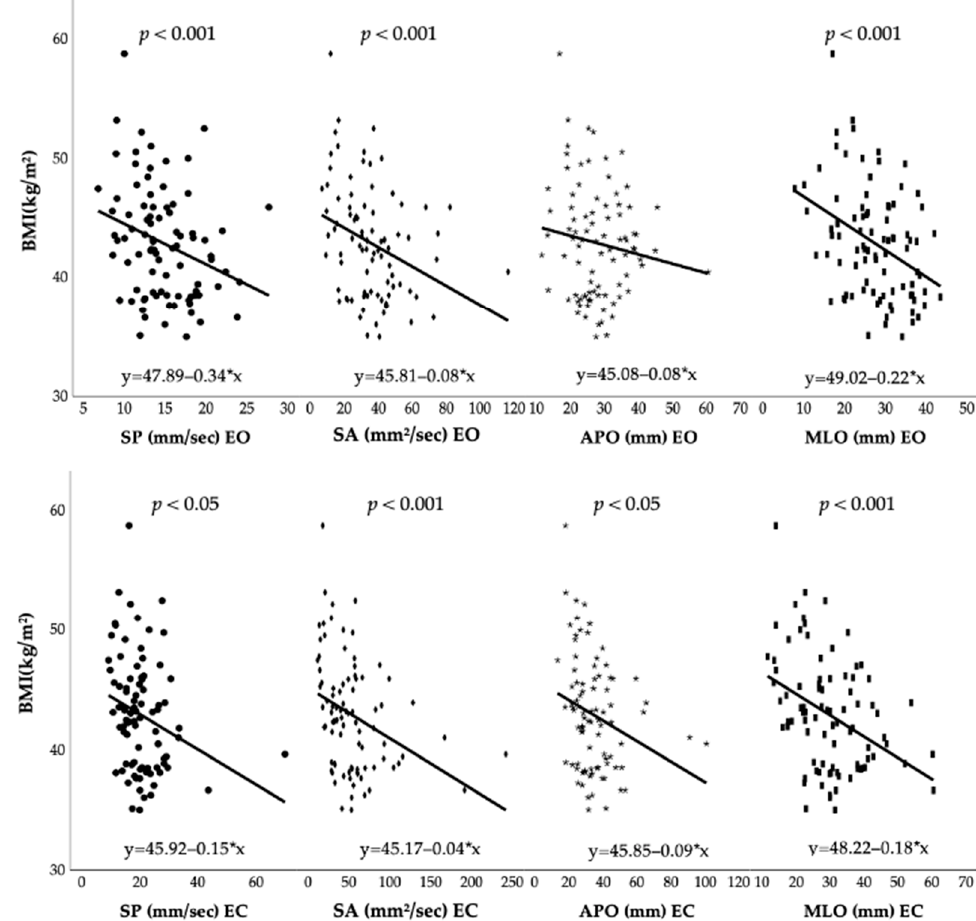
Figure 1. Pearson correlation between pre-surgery BMI and postural control outcomes. Abbrevia-